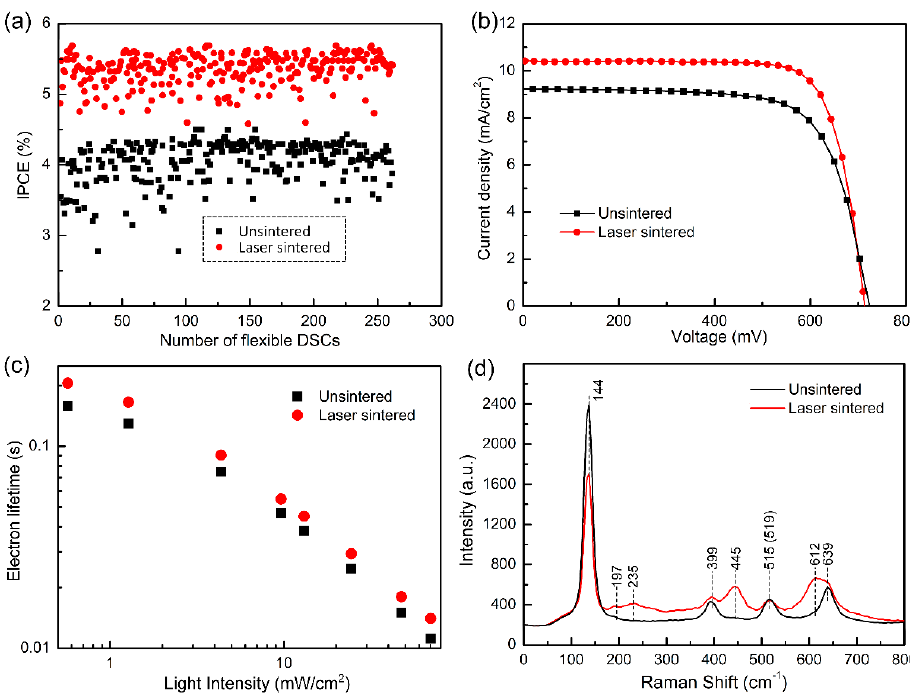
Figure 5. ( a ) Incident photon-to-electron conversion efficiency (IPCE) stability test, ( b ) current density-voltage, and ( c ) apparent recombination lifetime of the flexible dye-sensitized solar cells (DSCs) based on the laser sintered and unsintered TiO 2 films, ( d ) Raman spectra of the TiO 2 nanoparticle films before and after the laser sintering.